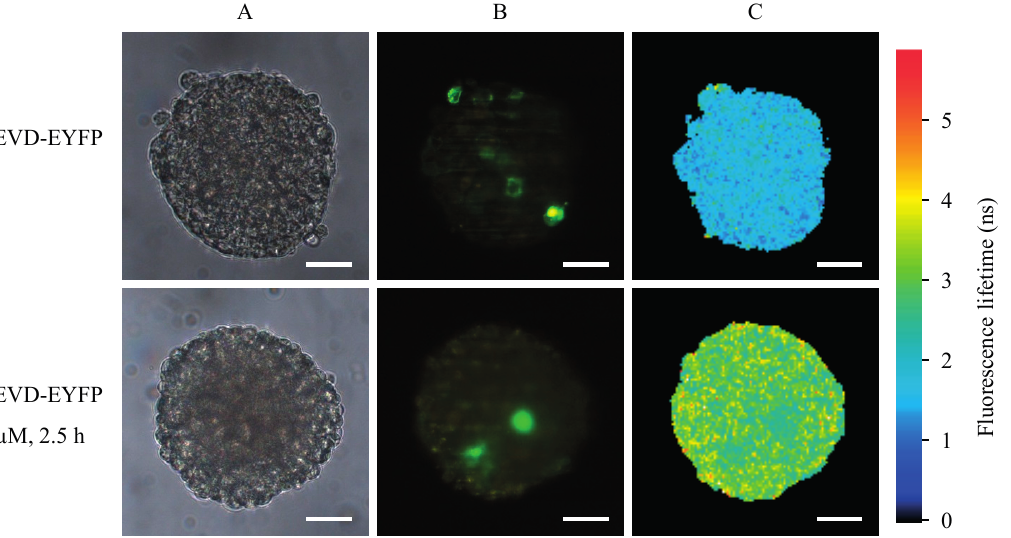
Figure 3. Transillumination ( A ), fluorescence intensity ( λ ≥ 515 nm); ( B ) and fluorescence lifetime (450–490 nm); ( C ) of HeLa cervical carcinoma cells transfected with a Mem-ECFP-DEVD-EYFP encoding vector prior to and subsequent to application of staurosporine (2 µM, 2.5 h). Light sheet based fluorescence microscopy of individual layers of a multicellular spheroid with 6–10 µm thickness each. Excitation wavelength: 391 nm. Scale bars: 50